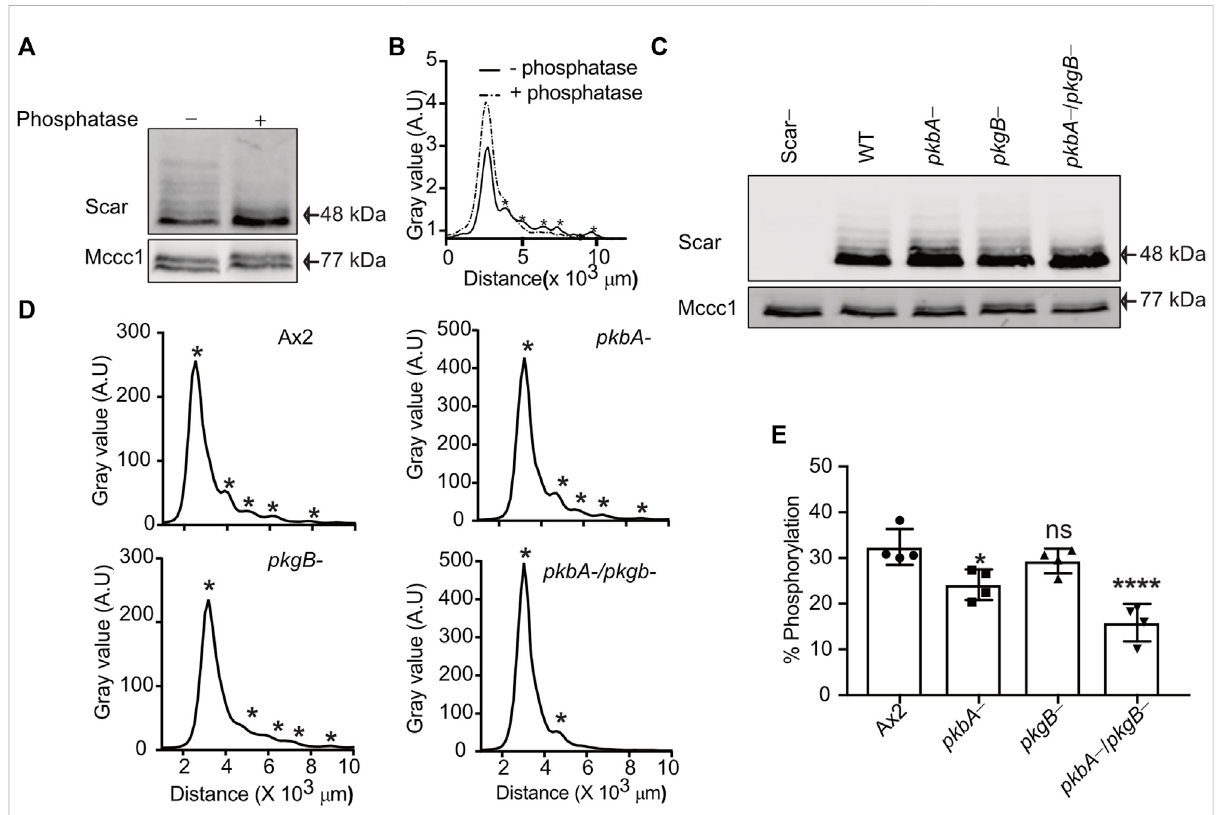
FIGURE 1 Phosphorylation of Scar is diminished in Dictyostelium pkbA-/pkgB -. (A) Assay of Scar phosphorylation. Ax2 cell lysates treated with phosphatase were analyzed by western blotting. (B) Density quanti fi cation shows multiple peaks (solid line) resolved into one (dotted line) after phosphatase treatment. Asterisks at the peaks represents Scar bands. (C) Assay of Scar phosphorylation in Ax2, pkbA -, pkgB - and pkbA -/ pkgB - cells. Whole cell lysates were analysed by western blotting. (D) Density quanti fi cation shows fl attening of multiple peaks (asterisks) in pkbA -, pkgB -, and loss in pkbA-/pkgB -. (E) Shows ratio of upper (more-phosphorylated) band to aggregate intensity of total Scar (bars show mean ± SD, n = 4 independent experiment, * p ≤ 0.05, **** p ≤ 0.0001, One-way Annova, Dunnett ’ s multiple comparison test). Mccc1 was used as loading